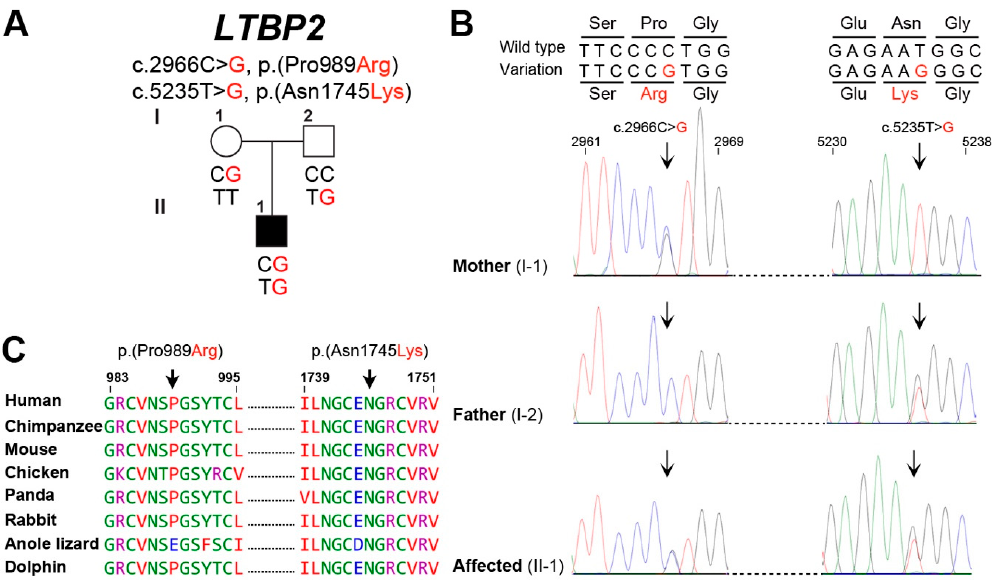
Figure 2. Compound heterozygous variants in latent transforming growth factor-beta-binding protein 2 ( LTBP2 ) are associated with juvenile open angle glaucoma (JOAG). ( A ) Family with JOAG showing segregation of two variants of LTBP2 . Affected individual is shown by filled symbol. ( B ) Shown also are the Sanger sequencing DNA chromatograms of LTBP2 for the normal (parents) and affected individuals. The mutated nucleotides are marked with arrows. ( C ) Amino acids conservation in orthologous species for the p.(Pro989Arg) and p.(Asn1745Lys) variants. The wild type residues (p.Pro989 and p.Asn1745) are represented with arrows. Table 1. Compound heterozygous variants of LTBP2 causing JOAG.